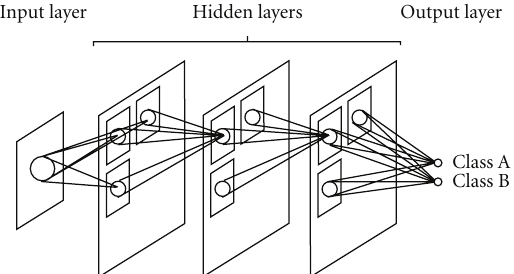
Figure 3: Architecture of a convolution NN (a class of PML). The convolution NN can be considered as a simplified version of the Neocognitron model, which was proposed to simulate the human visual system. The layers in the convolution NN are connected with local shift-invariant inter-connections (or convolution with a local kernel). The input and output of the convolution NN are images and nominal class labels (e.g., Class A and Class B),